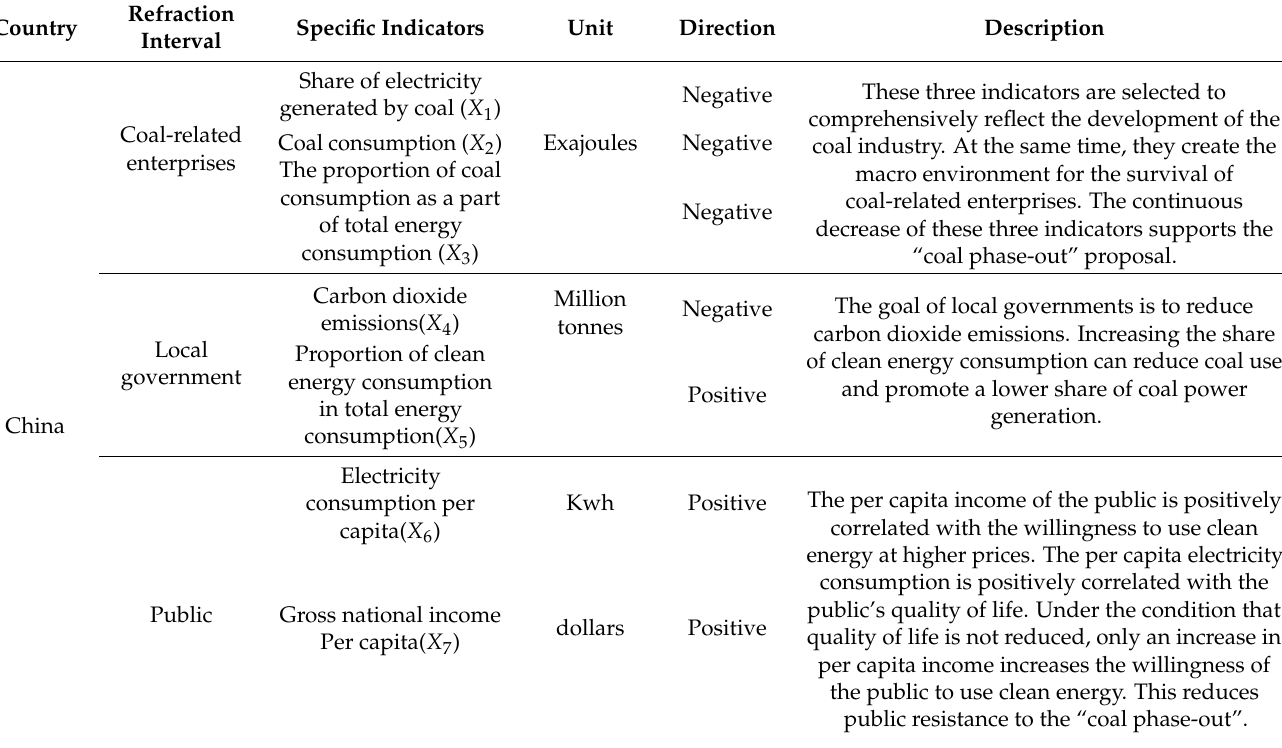
Table 13. Selection of relevant variables for the “coal phase-out” index